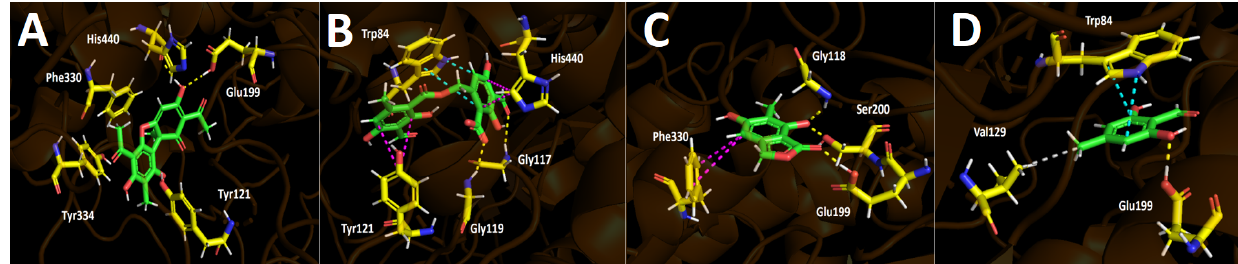
Figure 4. Predicted binding mode and predicted intermolecular interactions of the selected major compounds obtained from H. lugubris extract and the residues of the Torpedo Californica acetylcholinesterase ( Tc AChE) catalytic site. Yellow dotted lines indicate hydrogen bond interactions, cyan dotted lines represent π – π interactions, magenta dotted lines represent T-shaped interactions, and grey dotted lines represent hydrophobic interactions. ( A ) Usnic acid in the catalytic site; ( B ) barbatolic acid in the catalytic site; ( C ) 5,7-dihidroxy-6-methylphthalide in in the catalytic site; ( D ) atranol in the catalytic site.